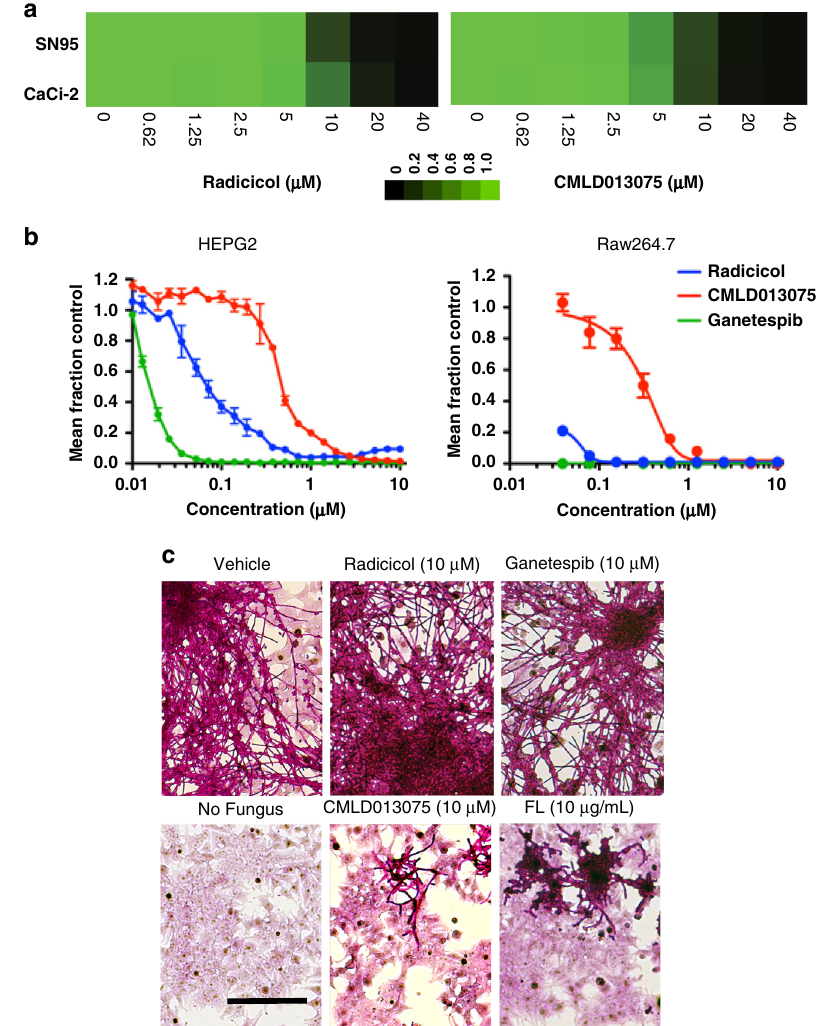
Fig. 6 Species-selective antifungal activity of Hsp90 inhibitor CMLD013075. a Relative growth inhibition by Hsp90 inhibitors of reference C. albicans strain (SN95) and a clinical isolate (CaCi-2) with resistance to FL. The effect of 48-hour exposure to each inhibitor over a twofold dilution series of concentrations is displayed in heat-map format. Each colored box represents the mean of duplicate determinations. Color scale for relative growth is provided to far right of panel, green: no inhibition to black: complete inhibition. The experiment was repeated as an independent biological replicate to con fi rm results. b Concentration-dependent inhibition of mammalian cell growth and survival after 3-day culture with Hsp90 inhibitors. Data points depict the mean of triplicate determinations, error bars, SD. The experiment was repeated as an independent biological replicate to con fi rm results. c Monolayer cultures of human HEPG2 cells in 6-well format were infected with C. albicans and then incubated with the indicated compounds for 48 h (FL, conventional antifungal fl uconazole). Cultures were then fi xed and stained by Periodic Acid-Schiff (PAS) technique to visualize fungal burden (dark red/purple signal) and underlying human cells (light pink signal). Representative fi elds from conventional light photomicrographs are presented at the same magni fi cation in all panels. The experiment was repeated in two independent biological replicates to con fi rm results. Scale bar, 100 μ